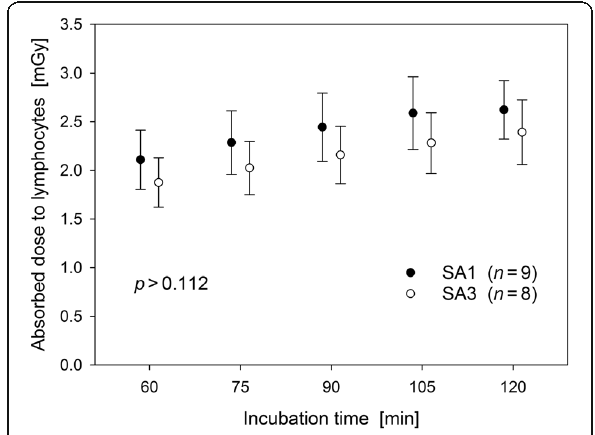
Fig. 4 Absorbed doses to blood/lymphocytes exposed to [ 18 F]FDG over 60 min in vivo and subsequently up to 60 min in vitro for SA1 and SA3. At each of the five incubation times, doses did not